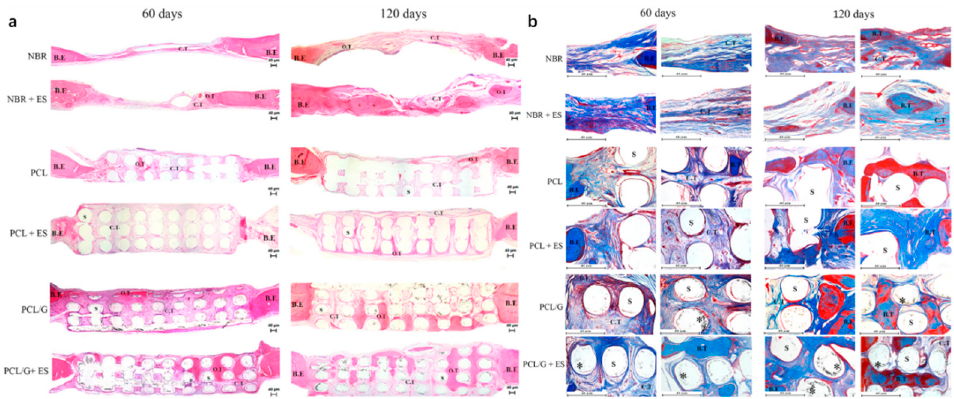
Figure 8. Photomicrography of the defect area after 60 and 120 days of in vivo bone regeneration test. ( a ) Attained with hematoxylin and eosin at 50 × magnification. ( b ) Stained with Masson Trichrome at 100 × magnification showing areas of the bone defect. In these images, it is possible to observe the bone edge (B.E), scaffold (S), connective tissue (C.T), bone tissue (B.T), graphene nanosheets (*) and matured / organized tissue (O.T) [32]. Reproduced with permission from Wang et al., Materials Science